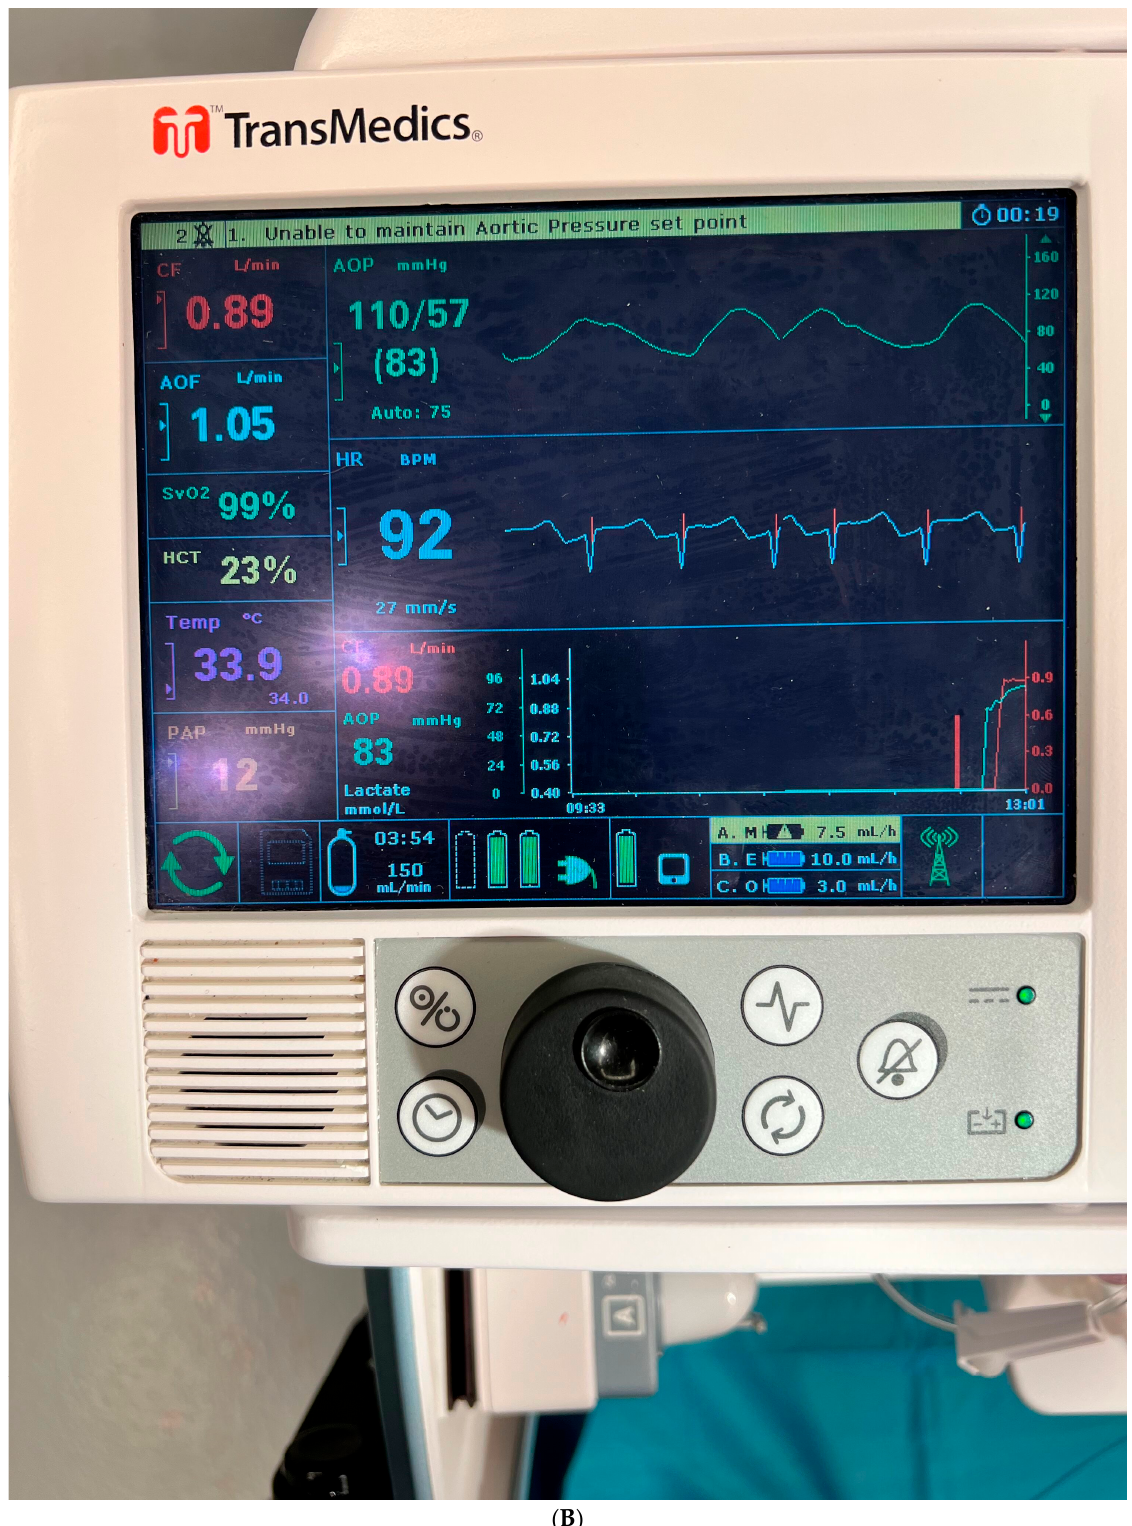
Figure 2. ( A ) Overview of the entire Organ Care System (OCS). Photo courtesy of Brandon Guenthart, MD. ( B ) View of the Organ Care System (OCS) Console. Several parameters are monitored while the allograft is in the console: aortic pressure, coronary flow, heart rate, pump flow, hematocrit, mixed venous oxygen saturation, blood temperature, and lactate levels. Photo courtesy of Brandon Guenthart, MD.